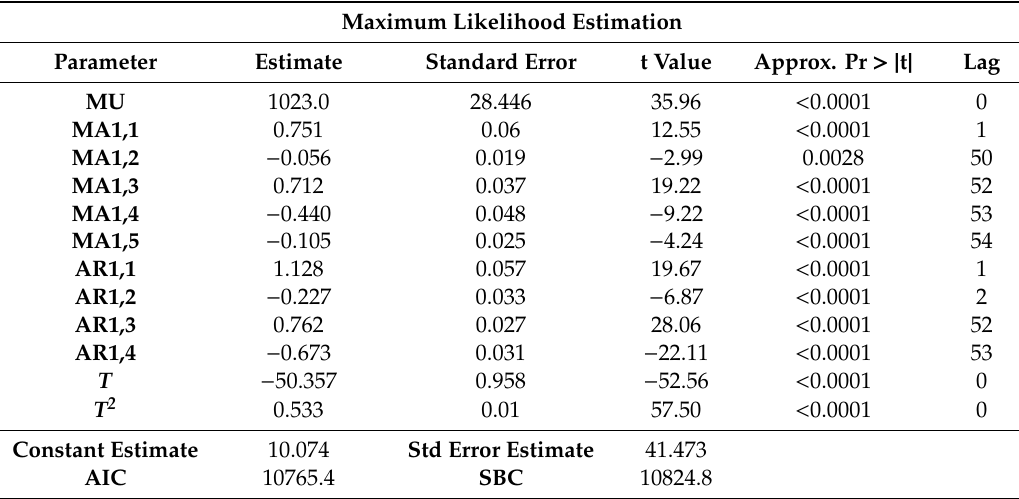
Figure A3. Normality Diagnostics of the Residuals of the Weekly ARMAX Model. Figure A.3. Normality Diagnostics of the Residuals of the Weekly ARMAX Model. Table A1. The Results for the Weekly ARMAX Table A.1. The Results for the Weekly ARMAX Model.